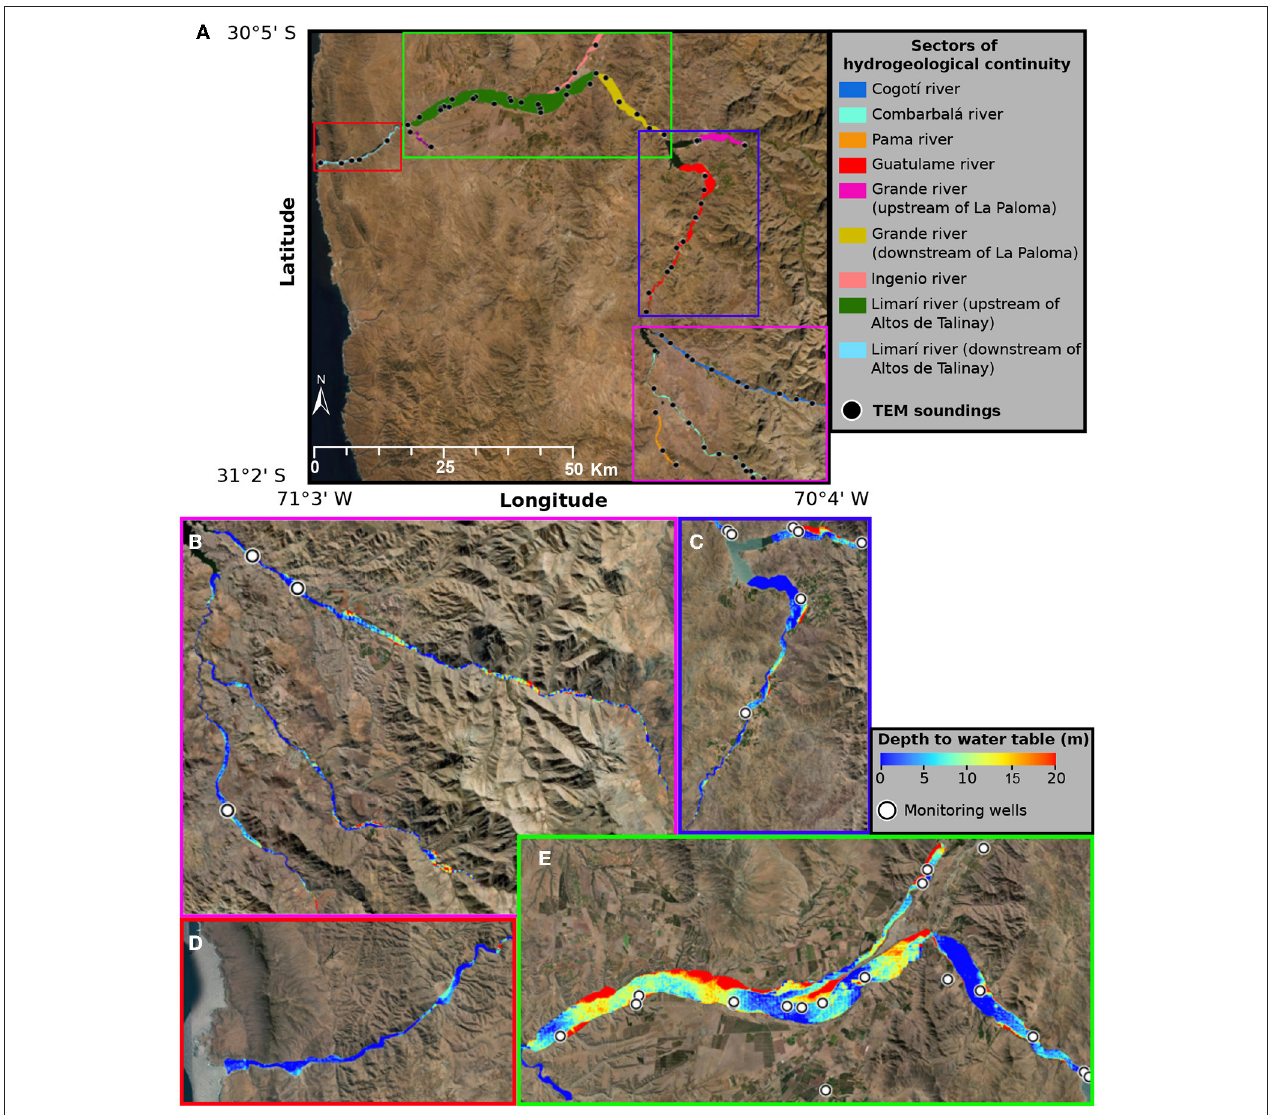
FIGURE 4 | Sectors of hydrogeological continuities and depth to the water table. (A) Overview map indicating the 10 sectors of hydrogeological continuity within the area of study, together with the location of the TEM soundings. (B–E) Depth to the water table obtained from the model Limarí 2020 (Flores and Aliaga, 2020) and DGA monitoring wells locations. Base map images from ESRI World Imagery. (B,C) Sectors crossing the Andes and transversal mountain ranges. (D,E) Sectors crossing the pediplanes of the coastal mountain range, the coastal mountain range and the littoral